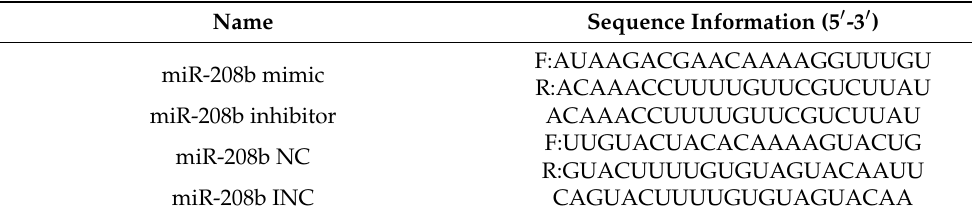
Table 1. The sequence information of RNA